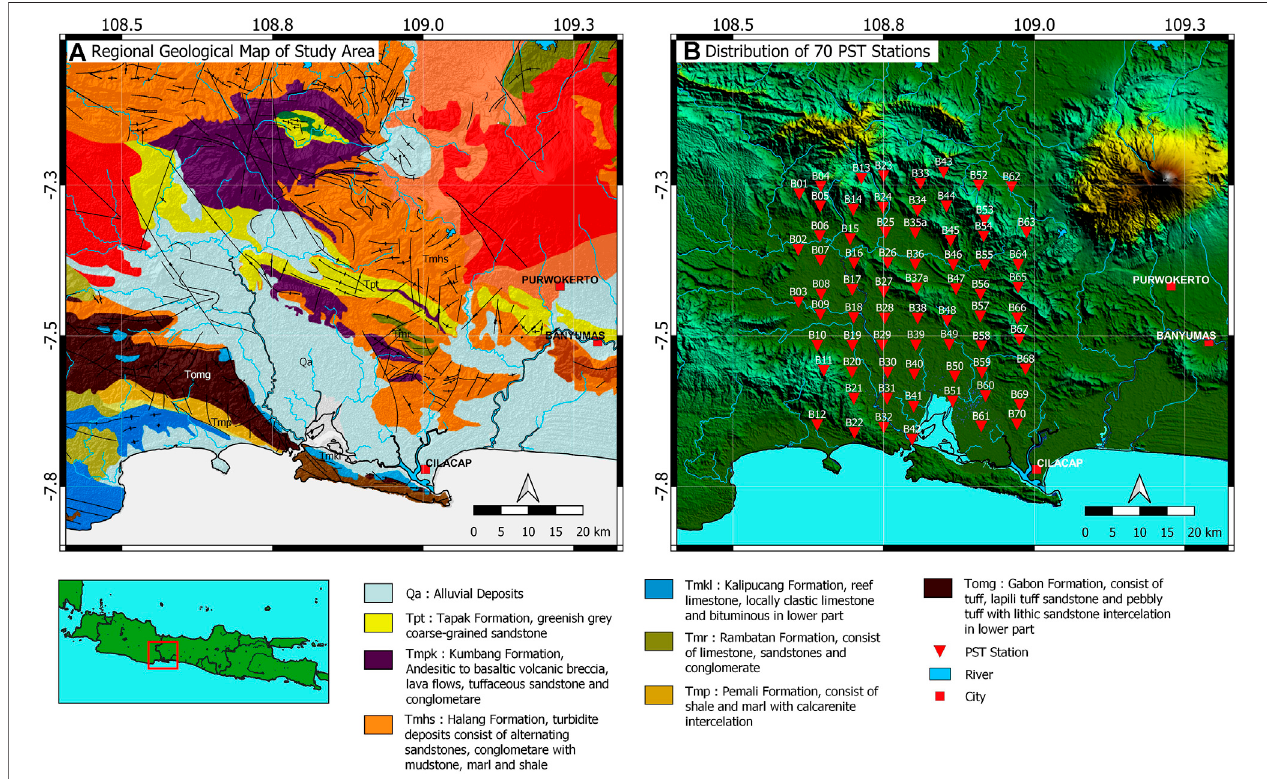
FIGURE 2 | (A) Regional geological map of the study area (modi fi ed from Budhitrisna, 1986; Supriatna et al., 1992; Kastowo, 1975; Simandjuntak and Surono, 1992; Djuri et al., 1996; Asikin et al., 1992) and (B) distribution of PST stations shown by red-colored inverted triangle.